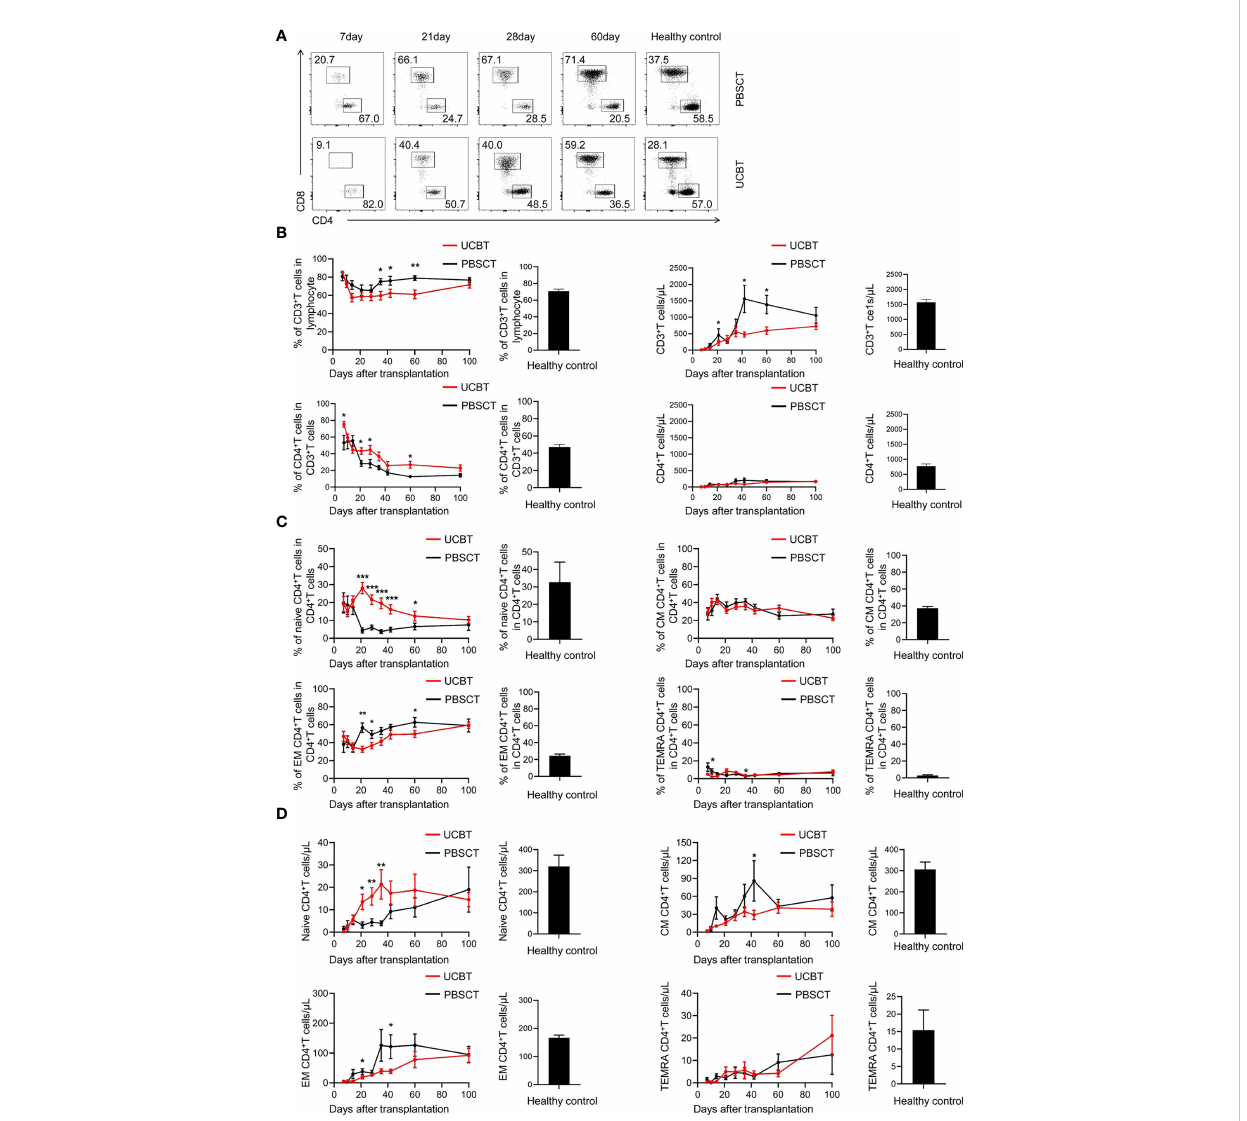
FIGURE 2 The expansion of CD4 + T cell subpopulations during the initial stages after UCBT or PBSCT. (A-D) Flow cytometry analysis of the peripheral blood mononuclear cells (PBMCs) in the UCBT and PBSCT group on days 7, 10, 14, 21, 28, 35, 42, 60, and 100 after HSCT. (A) Representative fl ow cytometry dot plots and the frequencies (percentages) of CD4 + T cells and CD8 + T cells during the early posttransplant period (day 7 to day 100) after UCBT and PBSCT. (B) The frequencies and the numbers of CD3 + T cells and CD4 + T cells during the early posttransplant period after UCBT and PBSCT. (C) The frequencies and (D) numbers of naïve CD4 + T cells, central memory CD4 + T cells, effector memory CD4 + T cells and terminally differentiated effector memory CD4 + T cells during the early posttransplant period after UCBT and PBSCT. The histogram shows data for the healthy control group. CM, central memory; EM, effector memory; TEMRA, terminally differentiated effector memory. The data was analyzed by the Mann – Whitney U test and represented as means ± standard error of the mean (SEM). * p <0.05; ** p <0.01; *** p